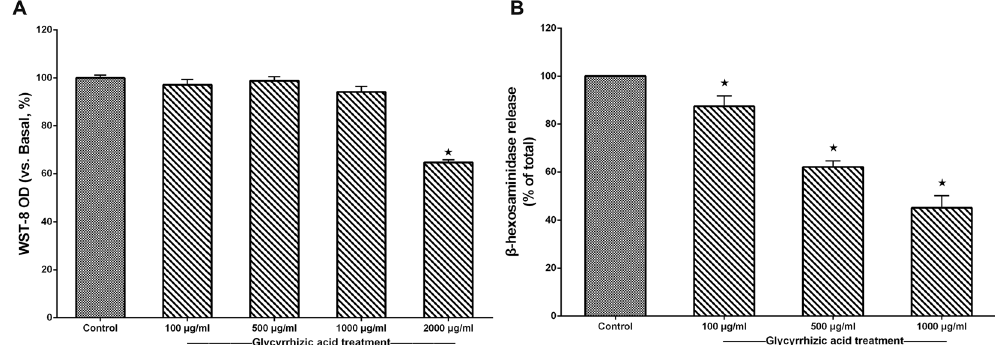
Figure 5. GA inhibited the degranulation of RBL-2H3 cells. * P < 0.05 as compared to the control group (n = 3). ( A ) WST-8 cell viability (%) assay for GA at various concentration (100, 500, 1000, 2000 μ g/mL). ( B ) β -hexosaminidase release (%) of RBL-2H3 cells after GA treatment.